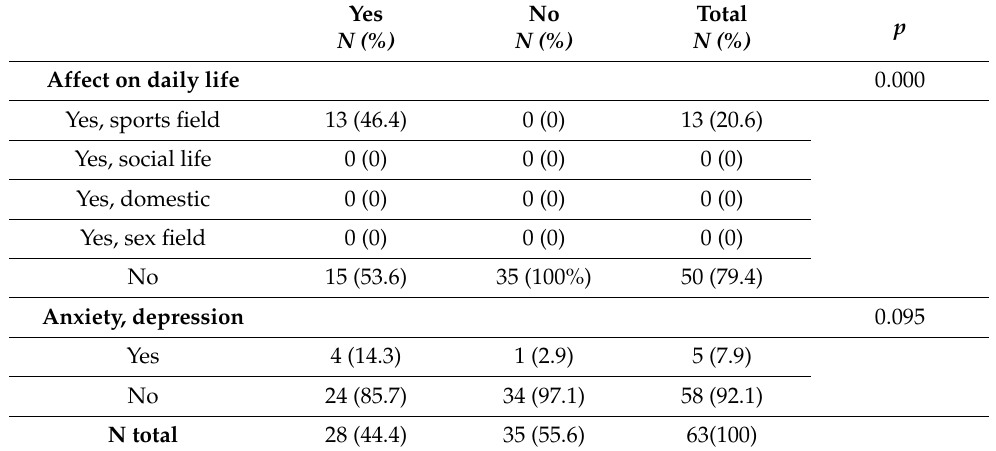
Table 3 relates some of the possible consequences of UI. Table 3. UI and